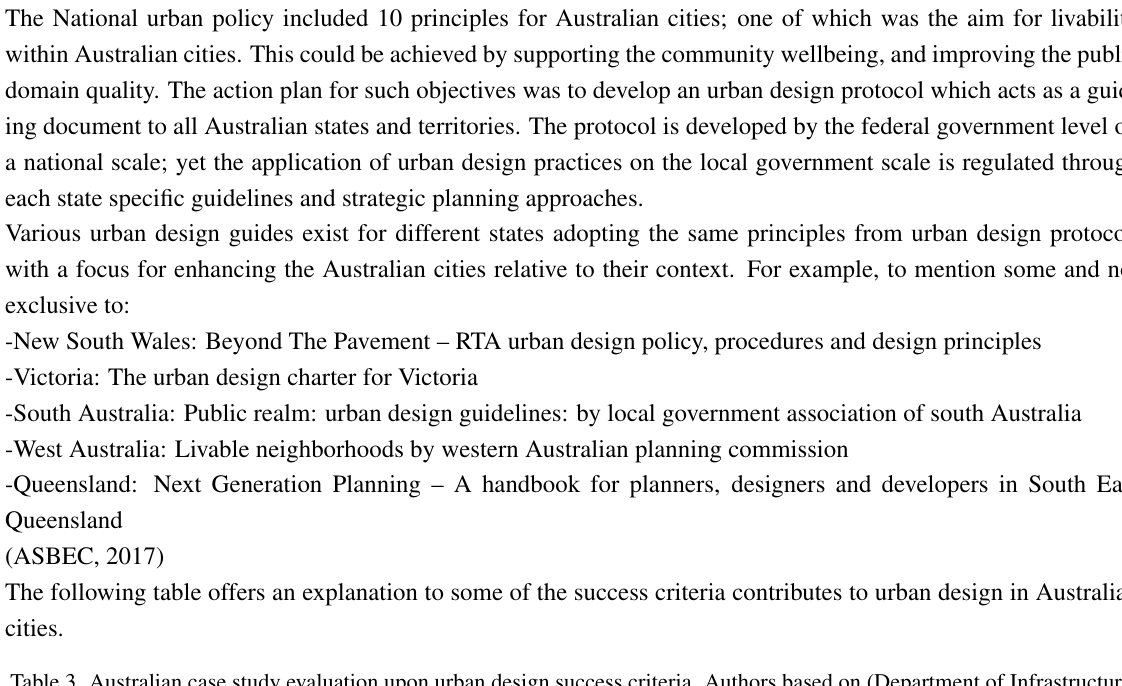
Table 3. Australian case study evaluation upon urban design success criteria. Authors based on (Department of Infrastructure and Transport, 2011; Palich & Edmonds, 2013; Australian Government, 2011; Australian Government, 2015; Jensen